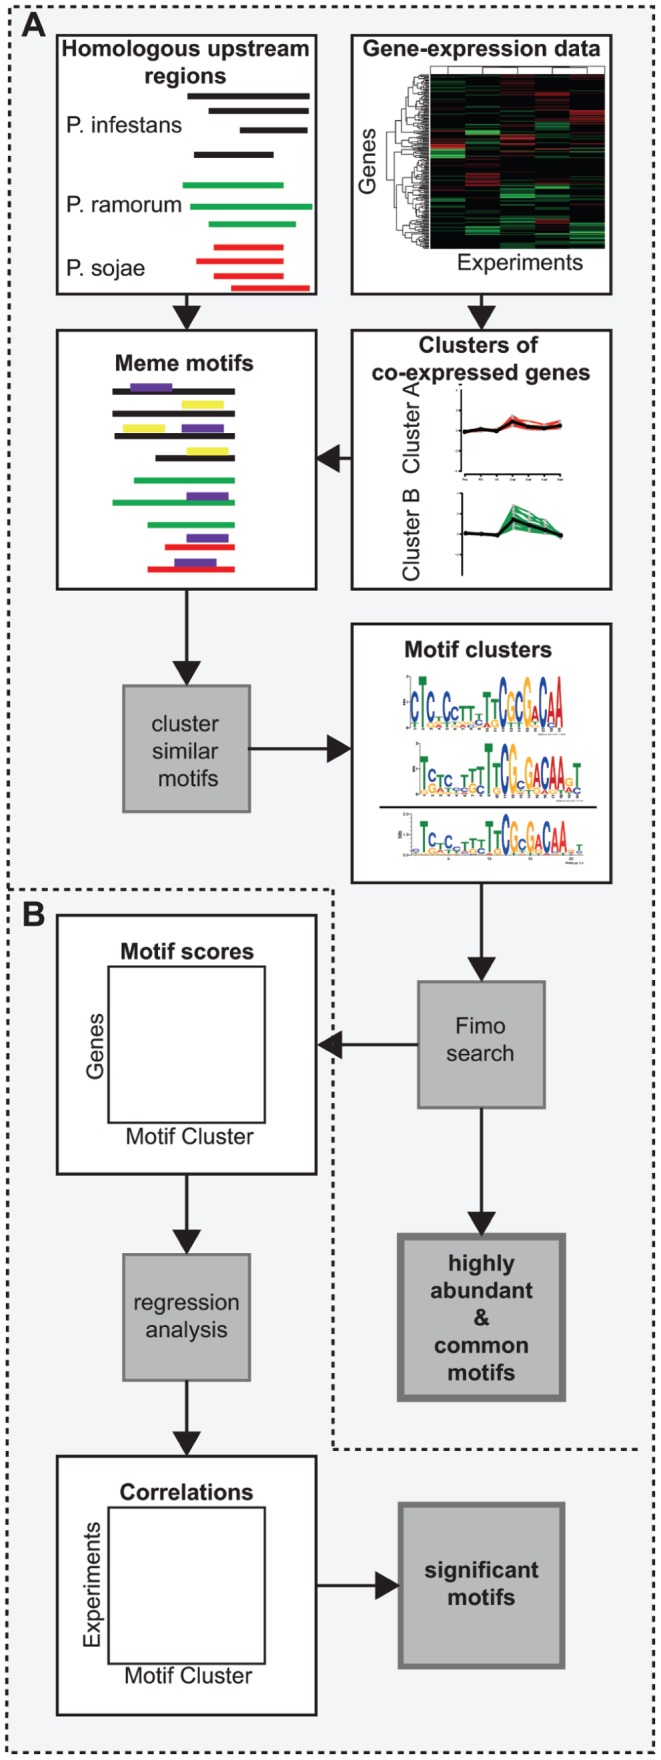
Analysis pipeline used to identify conserved DNA motifs in the three analyzed Phytophthora spp.(A) Co-expressed P. infestans genes were identified and their upstream regions were combined with the ones from orthologous genes in P. sojae and P. ramorum. In total 80 motifs were identified and similar motifs were grouped into 24 motif families of which 19 remained after conservation filtering. These were automatically and manually inspected for similarity to known eukaryotic promoter elements. (B) To further assess the biological relevance of the motifs, scores describing the occurrence of motifs in each individual upstream region were assigned. The motif score was correlated with the gene expression level of the downstream genes; an approach similar to the one applied by Bussemaker and colleagues. Subsequently, motifs that have a significant correlation with the expression level of genes during infection were identified (q<0.01).